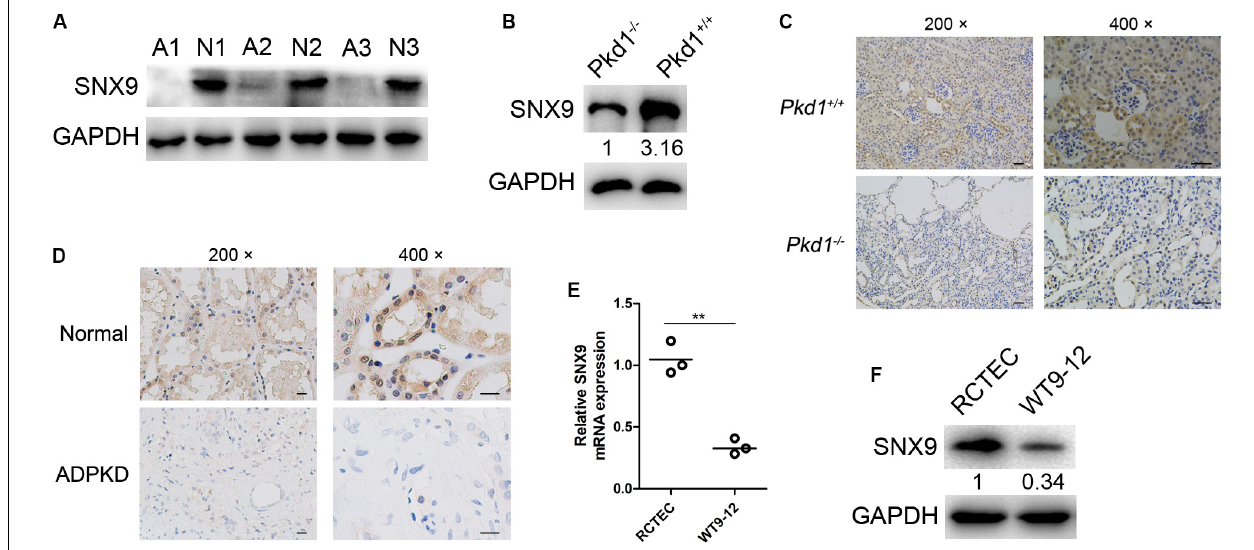
FIGURE 1 | SNX9 is significantly downregulated in ADPKD patients and Pkd1 − / − mice. (A) The protein expression levels of SNX9 were examined by western blot analysis, using kidney tissues from three ADPKD patients (A1, A2, and A3) and three normal controls (N1, N2, and N3). (B) The protein level of SNX9 was examined by western blot analysis using kidney tissues from wild-type mice ( Pkd1 + / + ) and Pkd1 knockout mice ( Pkd1 − / − ). (C) Immunohistochemistry (IHC) analysis of SNX9 expression was conducted, using kidney tissues from Pkd1 + / + and Pkd1 − / − mice. Representative IHC images showing the cellular distribution of SNX9. Scale bars, 200 µ m. (D) IHC analysis of SNX9 expression was conducted using kidney tissues from normal controls and ADPKD patients. Representative IHC images showing the cellular distribution of SNX9. Scale bars, 200 µ m. (E) The mRNA levels of SNX9 in RCTEC and WT9-12 cells were examined by qRT-PCR. Data are presented with scatterplots and mean values; n = 3. **indicates P < 0.01 by Student’s t -test. (F) The protein levels of SNX9 in RCTEC and WT9-12 cells were determined by Western blot